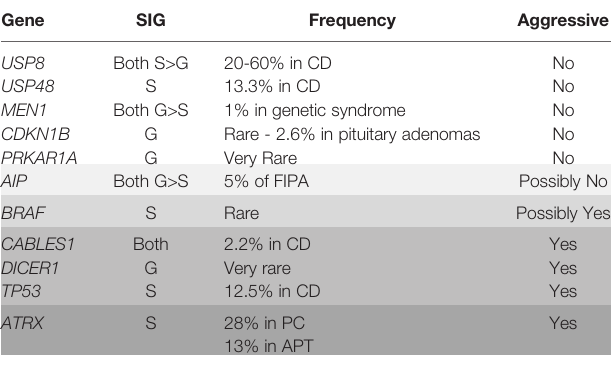
TABLE 1 | Causative Genes in Cushing ’ s disease and its association with